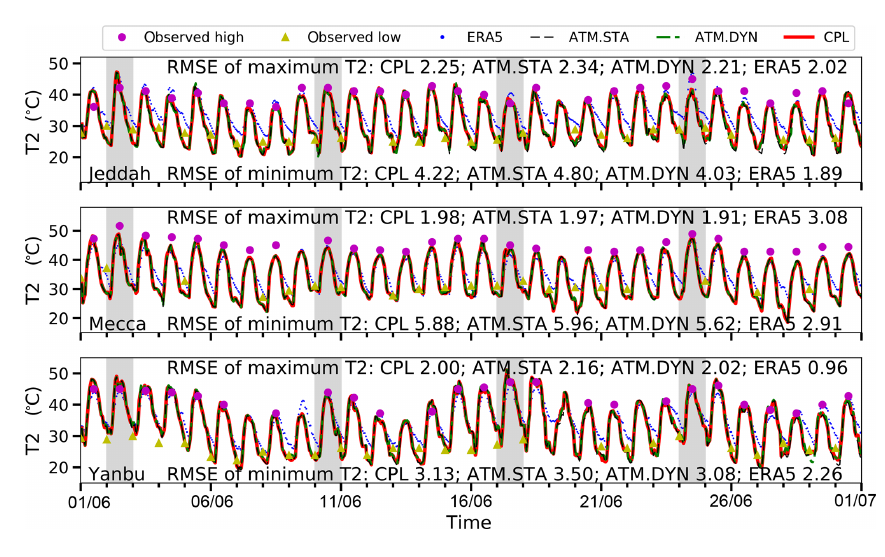
Figure 7. Temporal variation in the 2m air temperature at three major cities near the eastern shore of Red Sea (Jeddah, Mecca, Yanbu) as resulting from CPL, ATM.STA, and ATM.DYN. The temperature data are compared with the time series in ERA5 and daily high and low temperature in the NOAA national data center dataset. Note that some gaps exist in the NCDC ground observation dataset. Four representative heat events are highlighted in this figure.